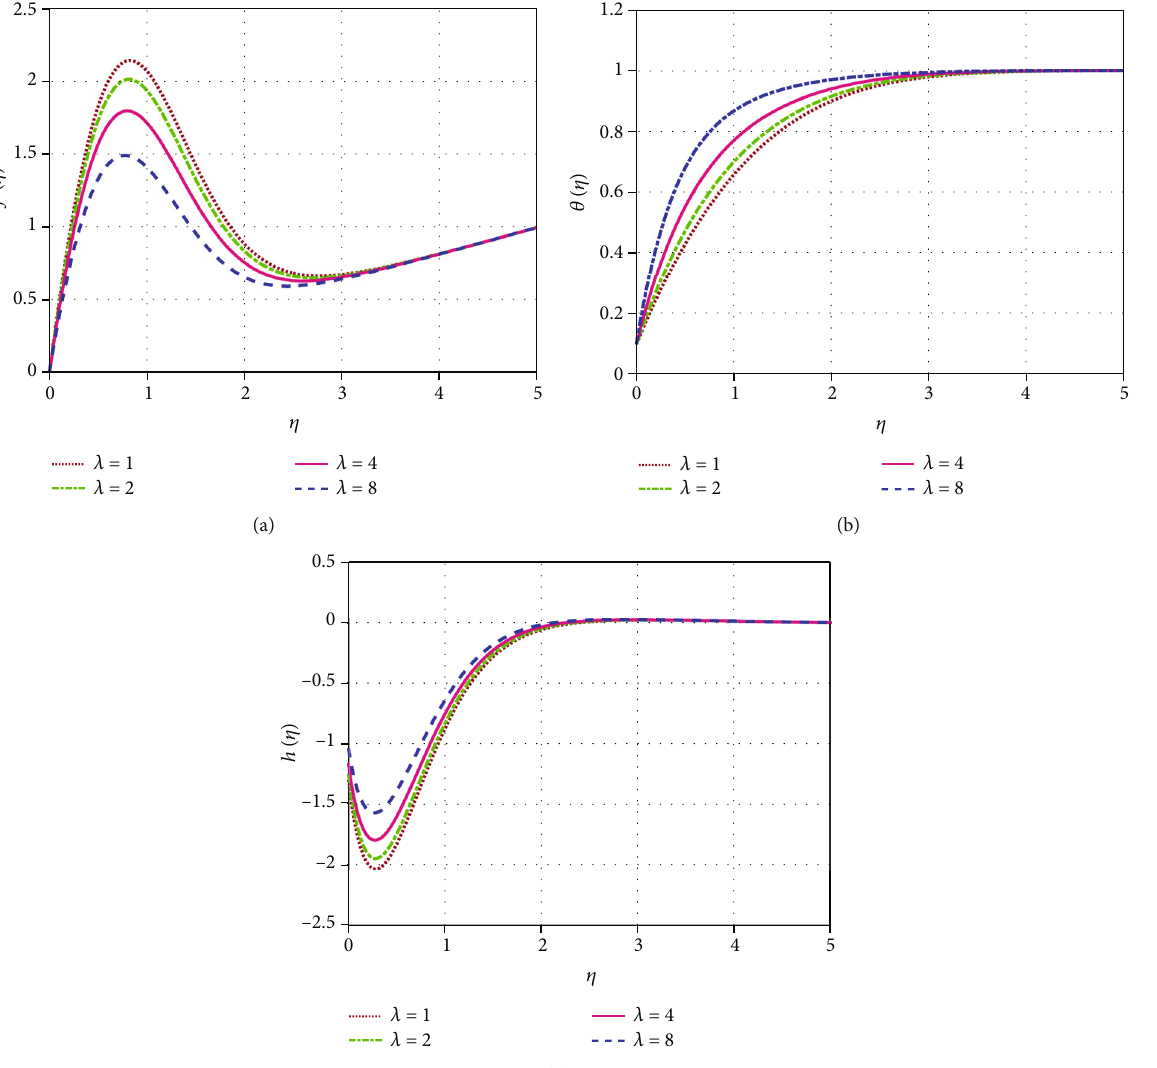
Figure 6: (a) Velocity, (b) concentration, and (c) micro-rotation pro fi les for thermophoresis variation with γ = 45 ° , M =2, c =0.5, R =0.5, Pr =0.71, Sc =0.22, L =0.33, ξ =3, K =0.5, Gr =10, and Gc 1 1